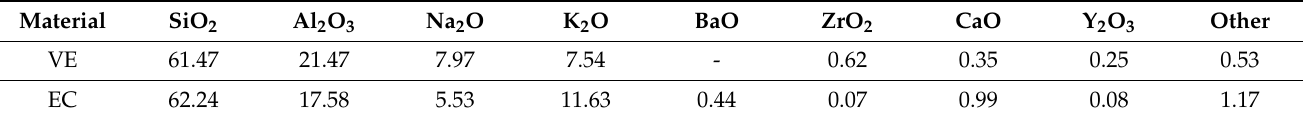
Table 2. Element concentration (%) of the crystalline phase determined with XRF analysis.